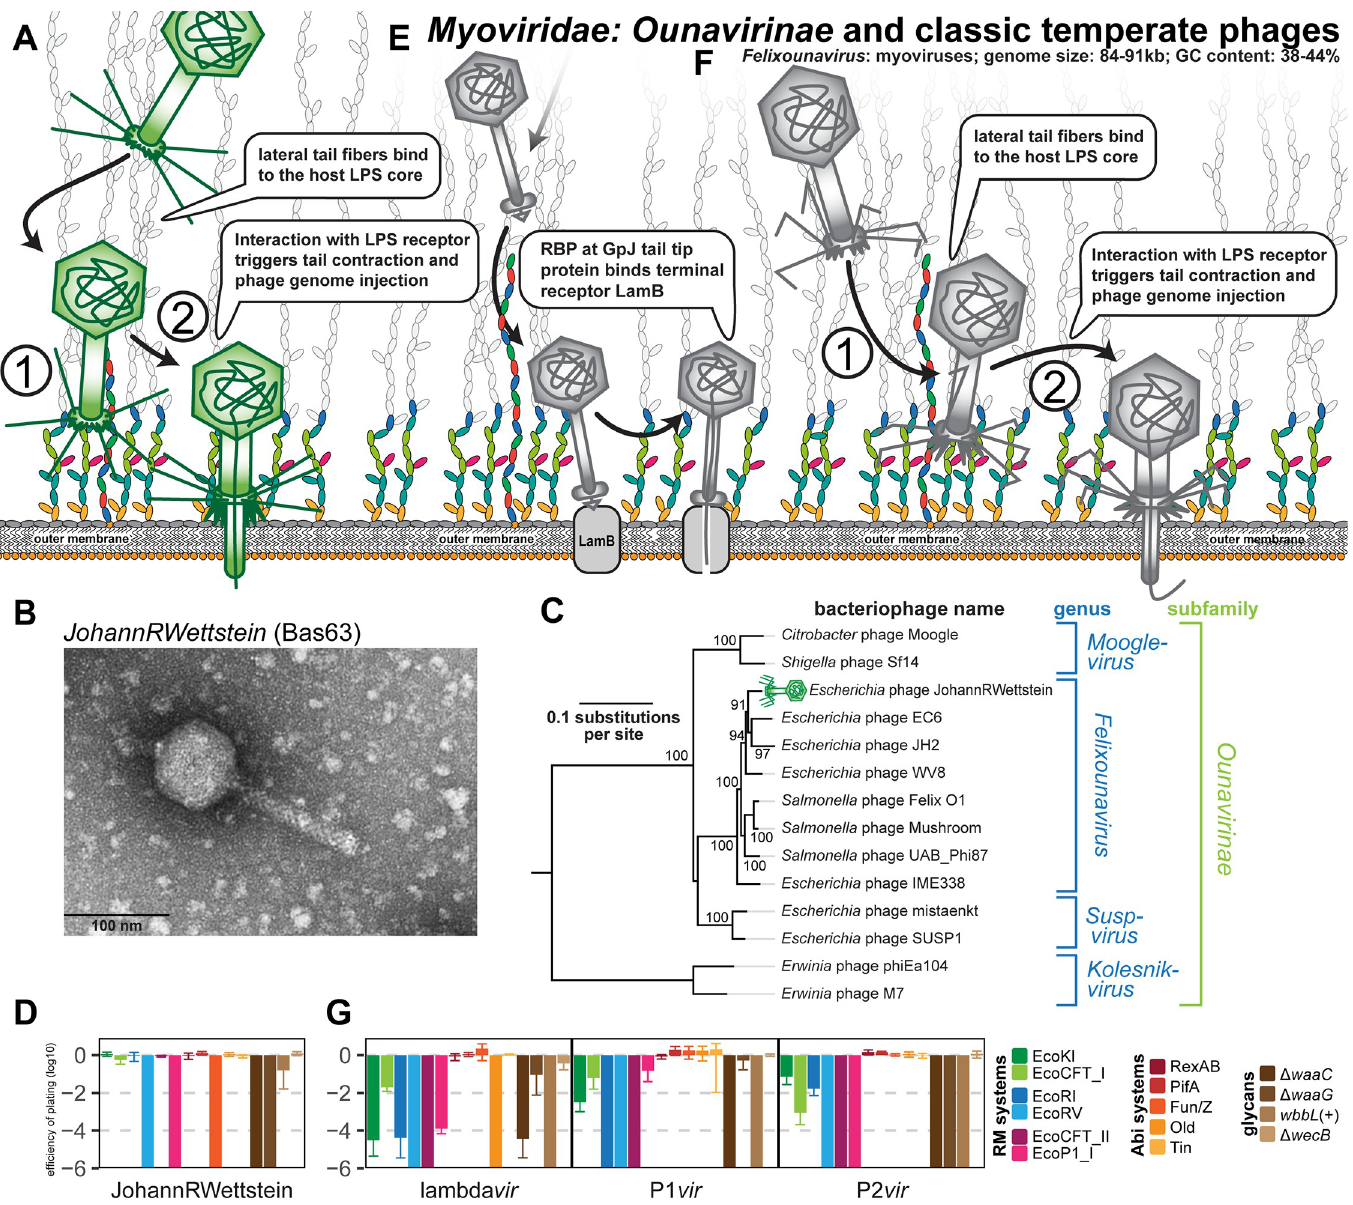
Fig 10. Overview of Myoviridae: Ounavirinae and classic temperate phages. (A) Schematic illustration of host recognition by Ounavirinae: Felixounavirus phages. Note that the illustration shows short tail fibers simply in analogy to Tevenvirinae or Vequintavirinae (Figs 7A and 8A), but any role for such structures has not been explored for Felix O1 and relatives. (B) Representative TEM micrograph of phage JohannRWettstein (Bas63). (C) Maximum-Likelihood phylogeny of the Ounavirinae subfamily of Myoviridae based on several core genes with bootstrap support of branches shown if > 70/100. The phylogeny was midpoint-rooted between Kolesnikvirus and the other genera. Our new isolate JohannRWettstein is highlighted by a green phage icon. (D) The results of quantitative phenotyping experiments with JohannRWettstein regarding sensitivity to altered surface glycans and bacterial immunity systems are presented as EOP. (E, F) Schematic illustration of host recognition by classic temperate phages lambda, P1, and P2. Note the absence of lateral tail fibers due to a mutation in lambda PaPa laboratory strains [93]. (G) The results of quantitative phenotyping experiments with the 3 classic temperate phages regarding sensitivity to altered surface glycans and bacterial immunity systems are presented as EOP. Data points and error bars in (D) and (G) represent average and standard deviation of at least 3 independent experiments. Raw data and calculations are available in S1 Data. Abi, abortive infection; EOP, efficiency of plating; LPS, lipopolysaccharide; RBP, receptor-binding protein; RM, restriction–modification; TEM, transmission electron microscopy.